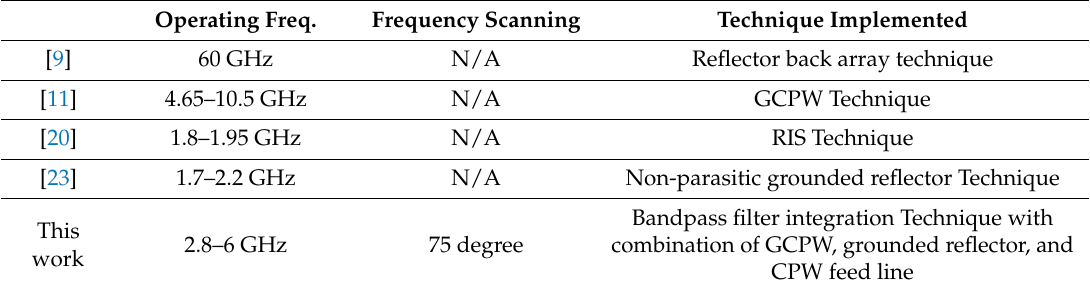
Table 1. Comparison between proposed work and related work published in